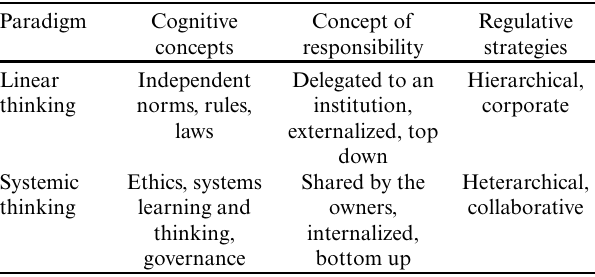
Table 3 . Defining the continuum of reflexivity within the context of organic consumer trust